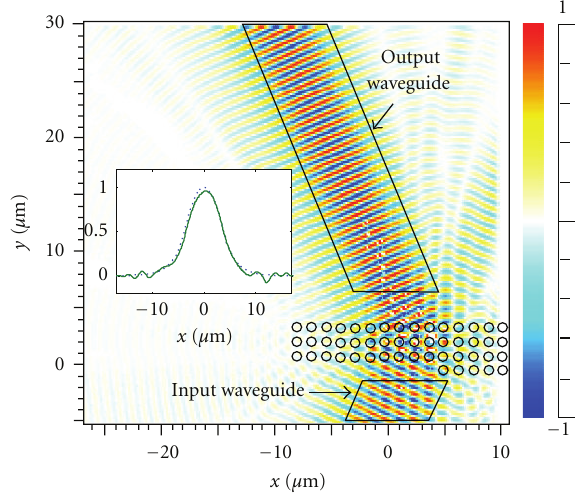
Figure 2: An ultra-compact 47.3 ◦ beam deflector (e ff ectively a wide-angle waveguide bend). Inset indicates the output beam profile (solid curve) is well matched to the waveguide mode profile (dotted